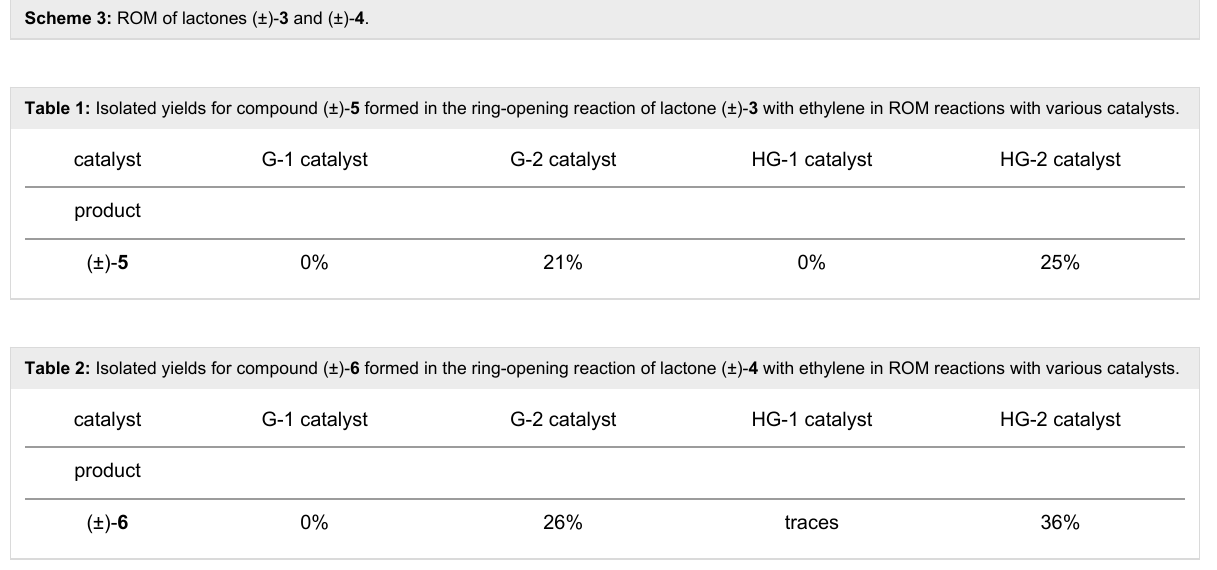
Scheme 3: ROM of lactones (±)- 3 and (±)- 4 .